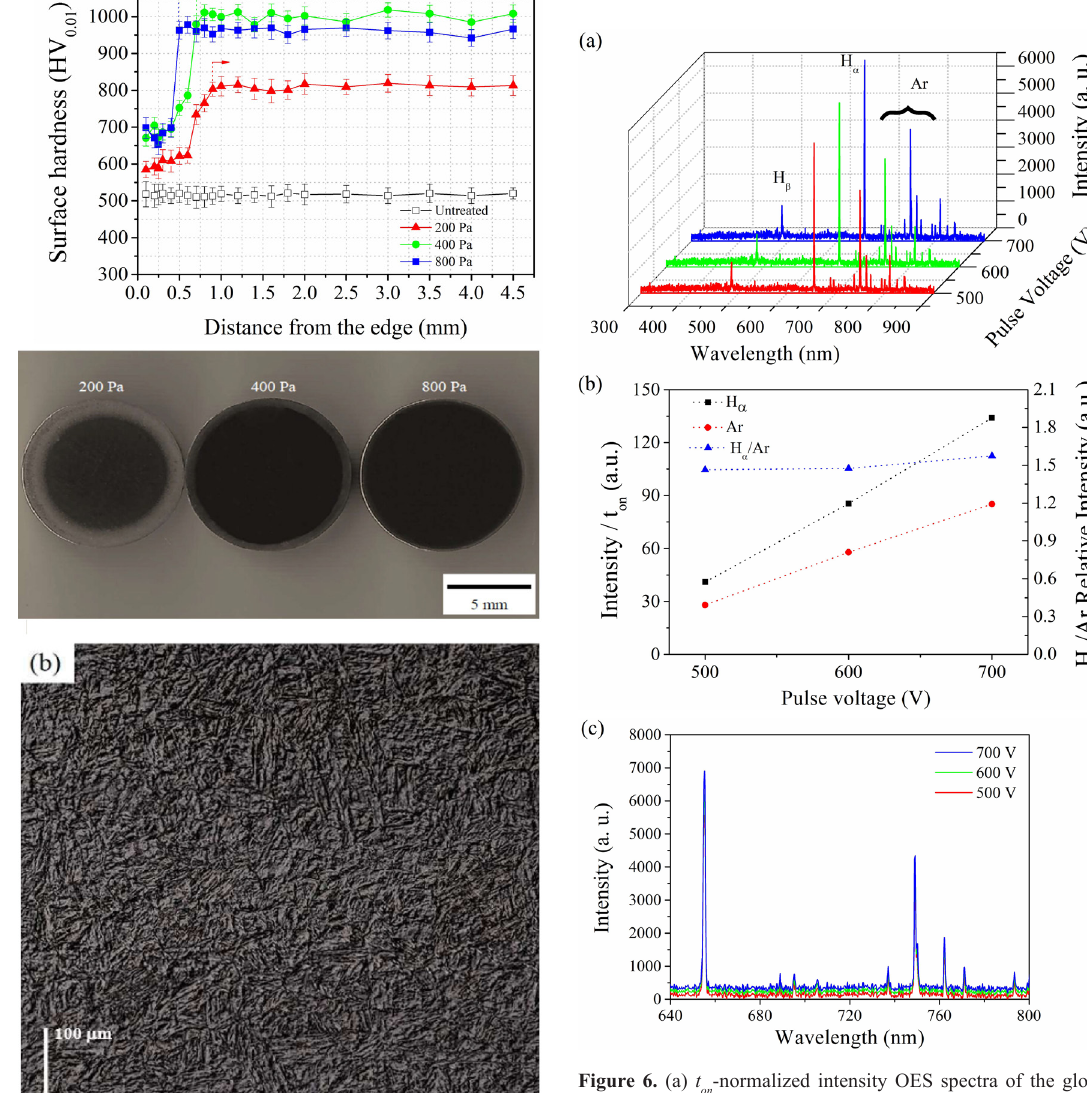
-normalized intensity OES spectra of the glow Figure 6. (a) t on discharge; (b) instantaneous H and Ar e.s. emission intensity α (represented by the Intensity / t axis spectrum evolution) and on H /Ar e.s. intensity ratio; and (c) global intensity OES spectra α (not divided by t ), for treatments carried out at 500, 600 and 700 on V. Treatments carried out at 450 °C, for 8 h, using 99.5% + 20% Ar) + 0.5% 2